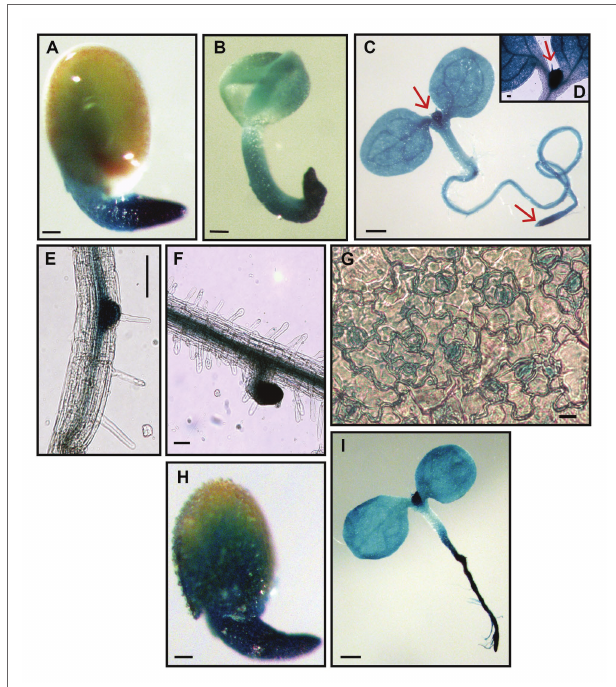
FIGURE 1 | Histochemical GUS staining of transgenic RPL10Apro:GUS plants. (A) Germinated seed, 22 h after stratification. (B) Germinated seed without the testa, 22 h after stratification. (C) Four-day-old seedling at cotyledon greening stage. (D) Shoot apical meristem from 4-day-old seedling. (E) Primary root during lateral root emergence. (F) Lateral root from 7-day-old seedling. (G) Abaxial epidermis peeled from leaves #1/2 of 8-day-old seedlings. (H) Germinated seed, 46 h after stratification, with 1 μ M abscisic acid (ABA). (I) Eight-day-old seedling at cotyledon greening stage, with 1 μ M ABA. Arrows point to shoot apical meristem (C,D) and root apical meristem (C) . Scale bars, 100 μ m (A-C,H,I) and 10 μ m (E-G)